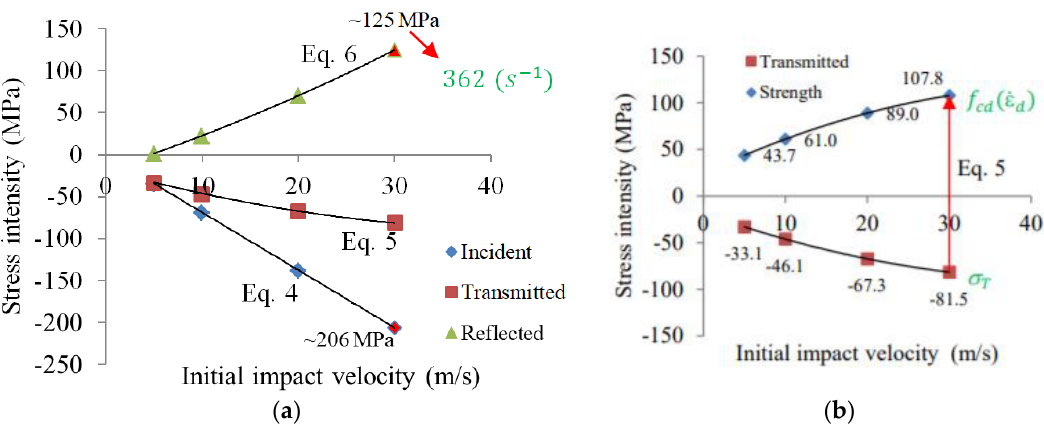
Figure 4. ( a ) Dependency of the incident, transmitted and reflected stress intensity for different initial impact velocities; ( b ) relation between the dynamic concrete strength and the intensity of the transmitted wave.